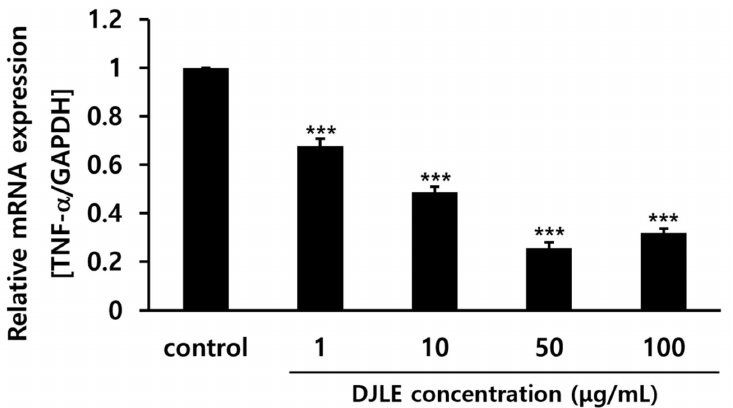
Figure 3. Tumor necrosis factor (TNF)- α gene expression levels in human periodontal ligament cells with different concentrations of Daphne jejudoensis leaf extract (DJLE) (1, 10, 50, and 100 µ g/mL). *** p < 0.001 vs. control.